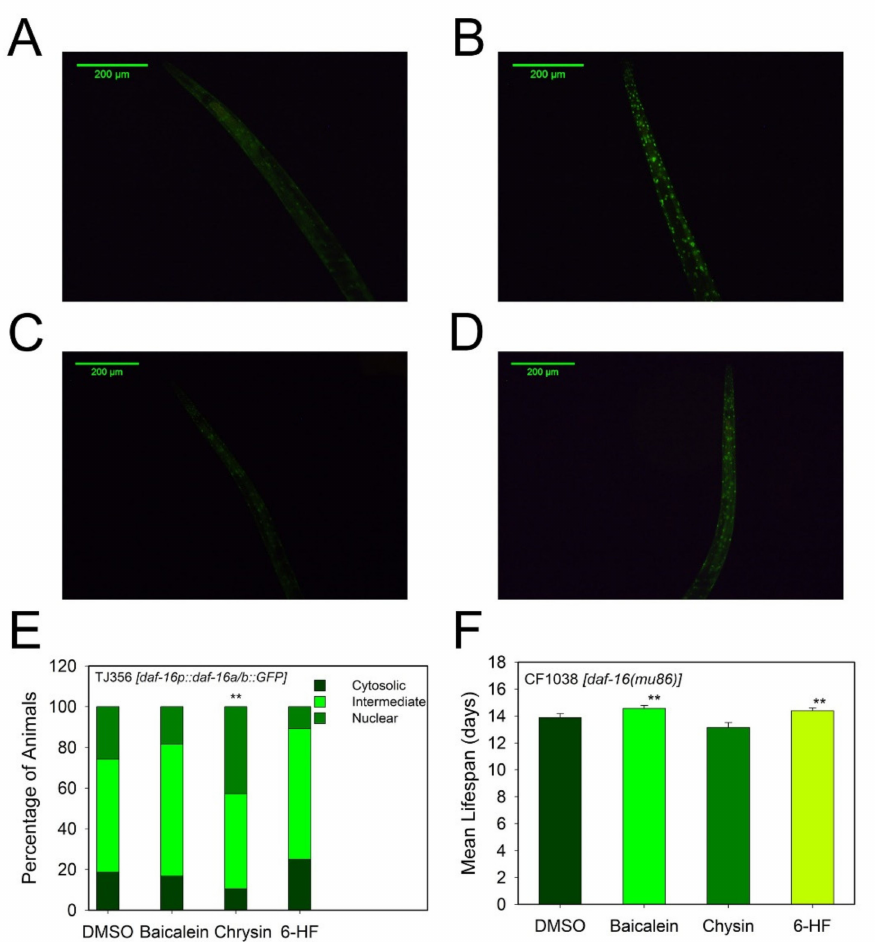
Figure 5. Biological confirmation of flavonoids’ activities in the insulin signaling pathway. Repre- sentative images are shown for ( A ) TJ356 ( daf-16::GFP ) negative control, ( B ) localization of TJ356 ( daf-16::GFP ) in worms treated with DMSO, ( C ) localization of TJ356 ( daf-16::GFP ) after baicalein treatment and ( D ) ( daf-16::GFP ) localization after chrysin treatment. ( E ) Histogram summarizing the fraction of TJ356 worms with cytosolic, intermediate or nuclear localization of DAF-16 ( daf-16::GFP ) after flavonoid treatment. ( F ) Mean lifespan of CF1038 ( daf-16 (mu86) ) worms treated with 25 µ M of baicalein, 10 µ M of chrysin or 100 µ M of 6-hydroxyflavone. Data are represented as mean ± S.D, n > 10; two independent experiments were performed; ** significant at p ≤ 0.05 by ANOVA test. Scale bar: 200 µ m, magnification 10 ×